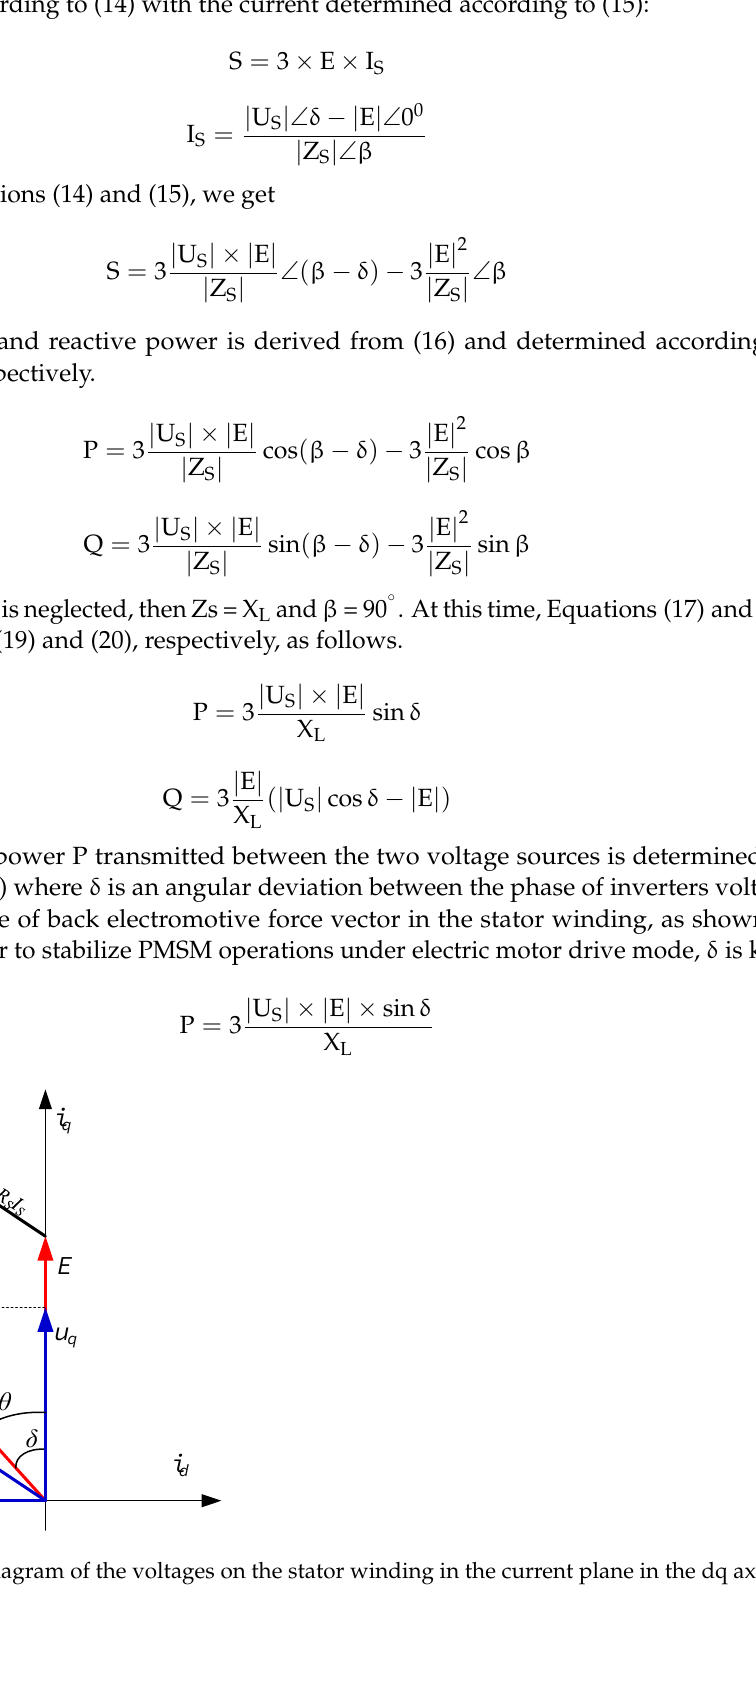
Figure 3. Equivalent circuit of PMSM in steady-state [33].